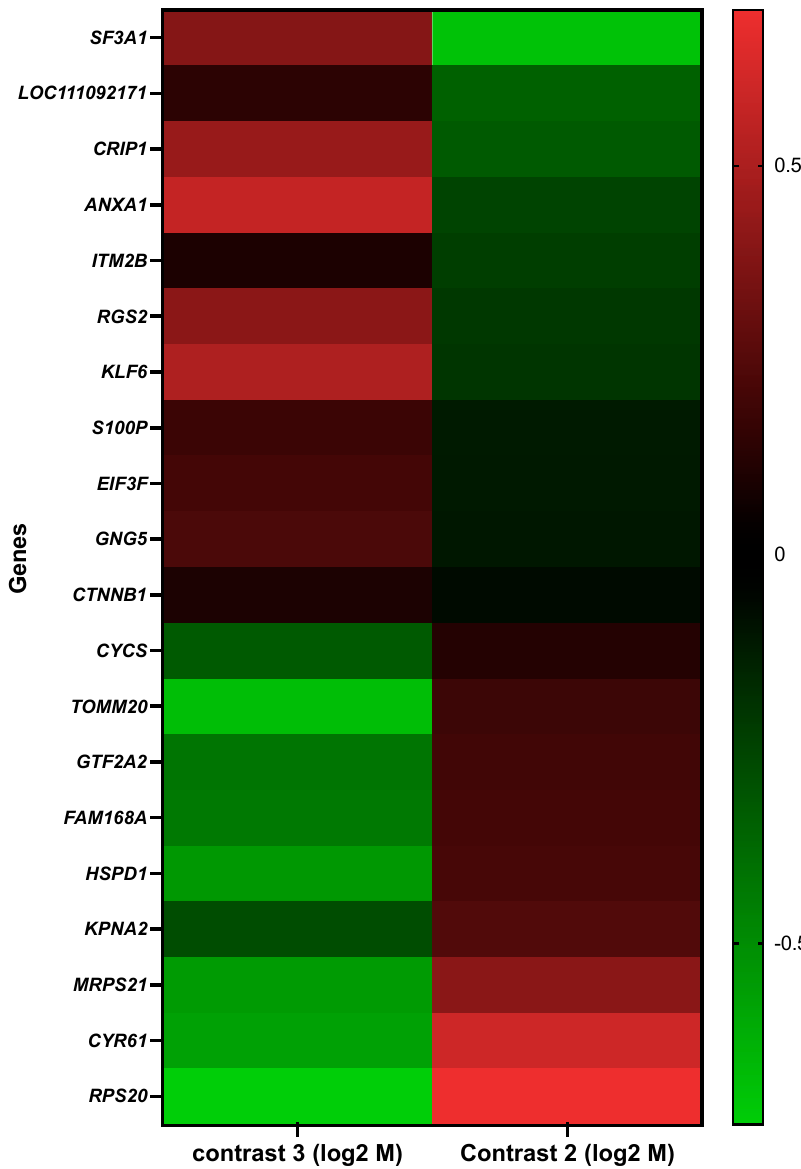
Figure 10. A heat map representing the color-coded expression levels (log-ratio M values) of DEGs upregulated in the IBD enteroids and downregulated in the IBD colonoids and vice versa between the IBD enteroids and colonoids following LPS stimulation. The log-ratio M values represent the log(R/G) (log fold change) [44]. The detailed information on genes is presented in Table 12. The LPS-stimulated genes that exhibited the opposite expression trends between the